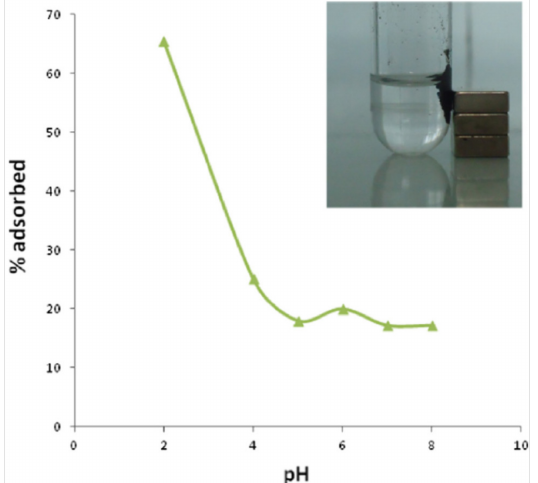
Figure 5. The effect of the initial pH for the adsorption of arsenate As(V) by FeNP/MFC at room temperature, with the adsorbent dosage of 0.067 g, while inset is an illustration of magnetic separa- tion [128]. Copyrights: Elsevier,